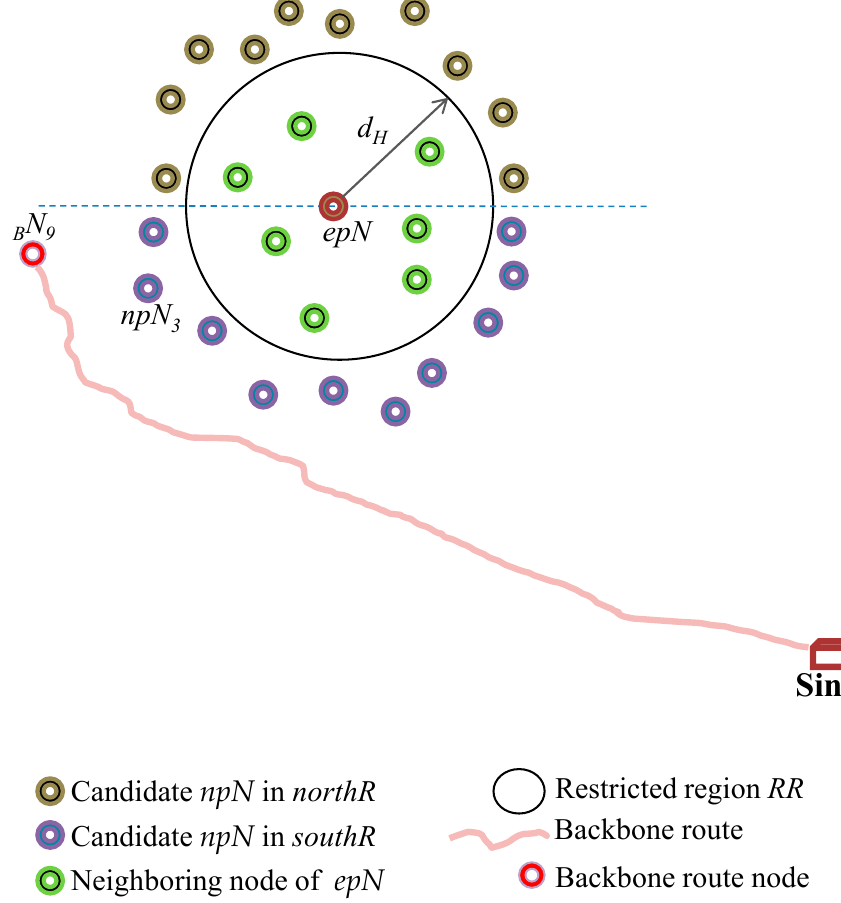
Figure 4. Configuration of the sensor nodes in the proposed two-level phantom with a backbone (PhaT) protocol.